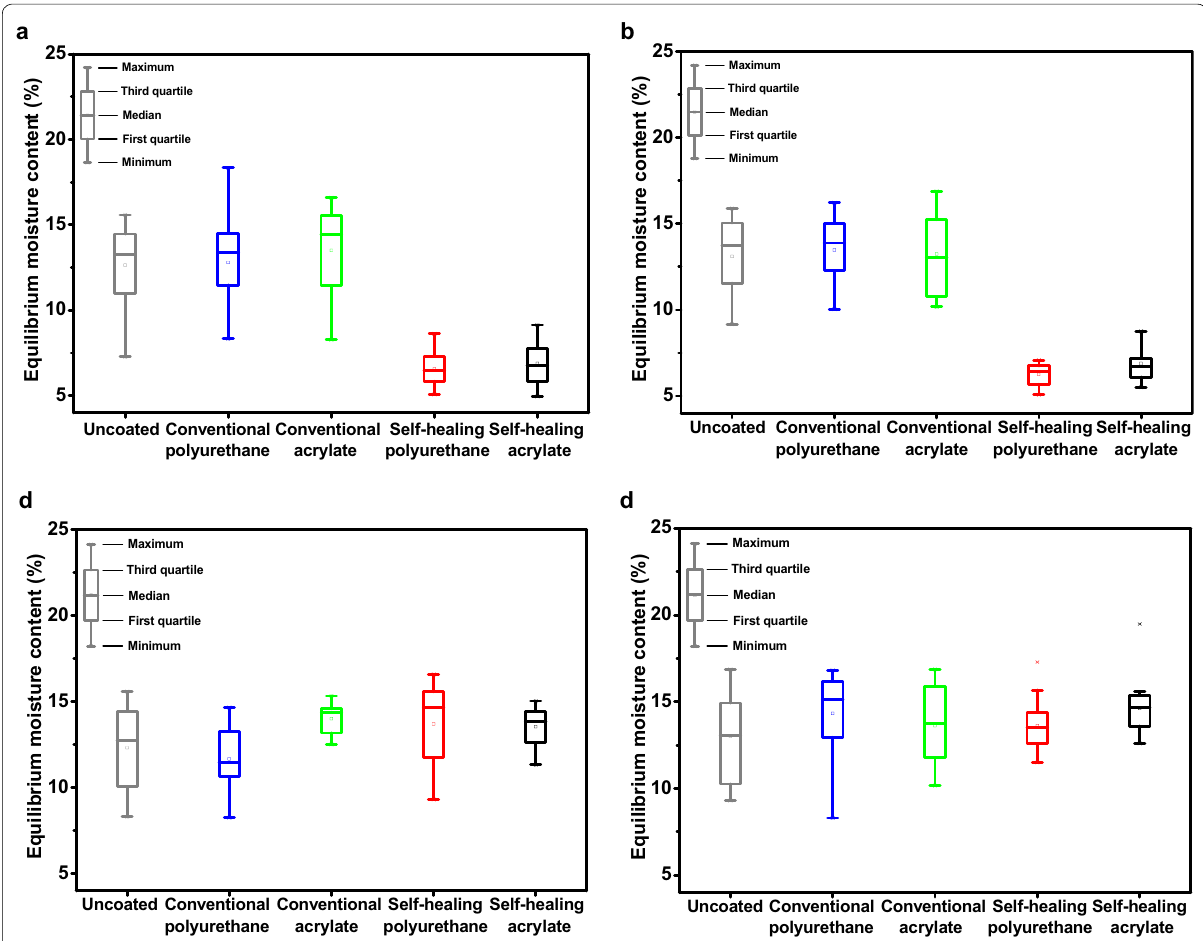
Fig. 6 Equilibrium moisture content of preservative-treated bamboo after a , b 720 and c , d 2160 h of accelerated corrosion